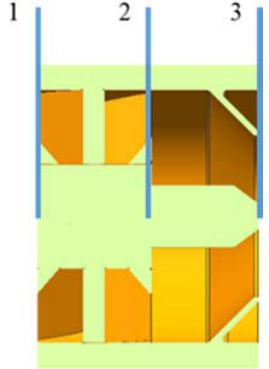
Figure 2. Three cross sections of LDI module.